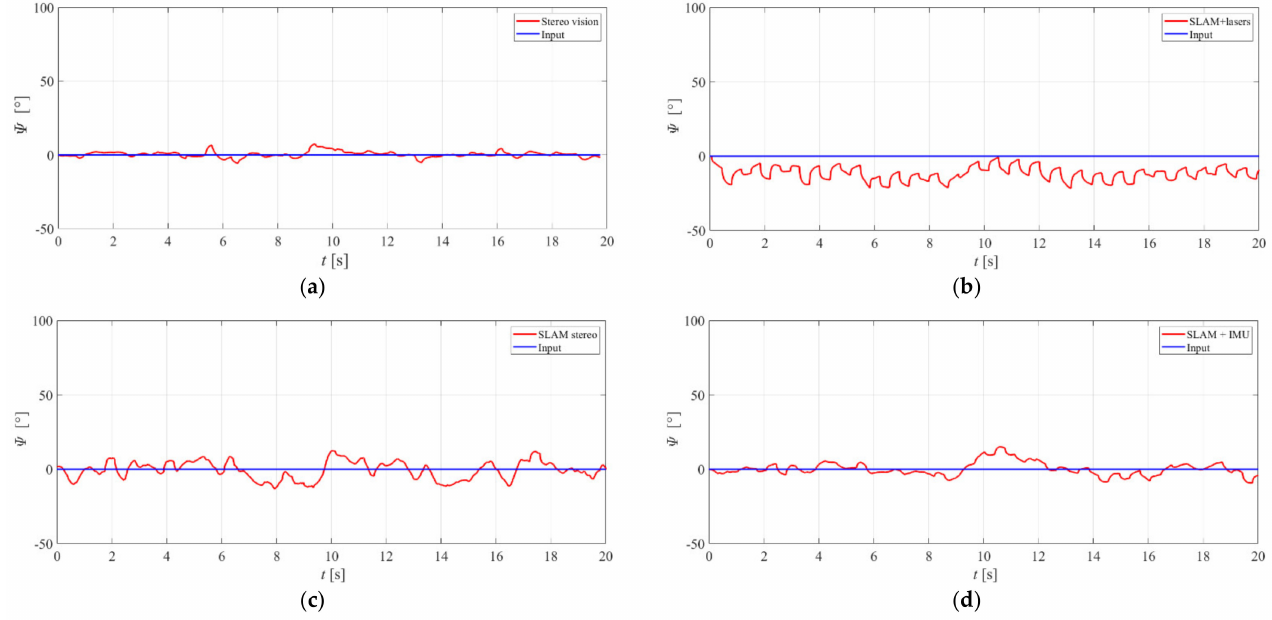
Figure 16. Heading control for velocity equals 0.2 m/s: ( a ) stereo vision; ( b ) SLAM lasers; ( c ) SLAM stereo; ( d ) SLAM IMU.